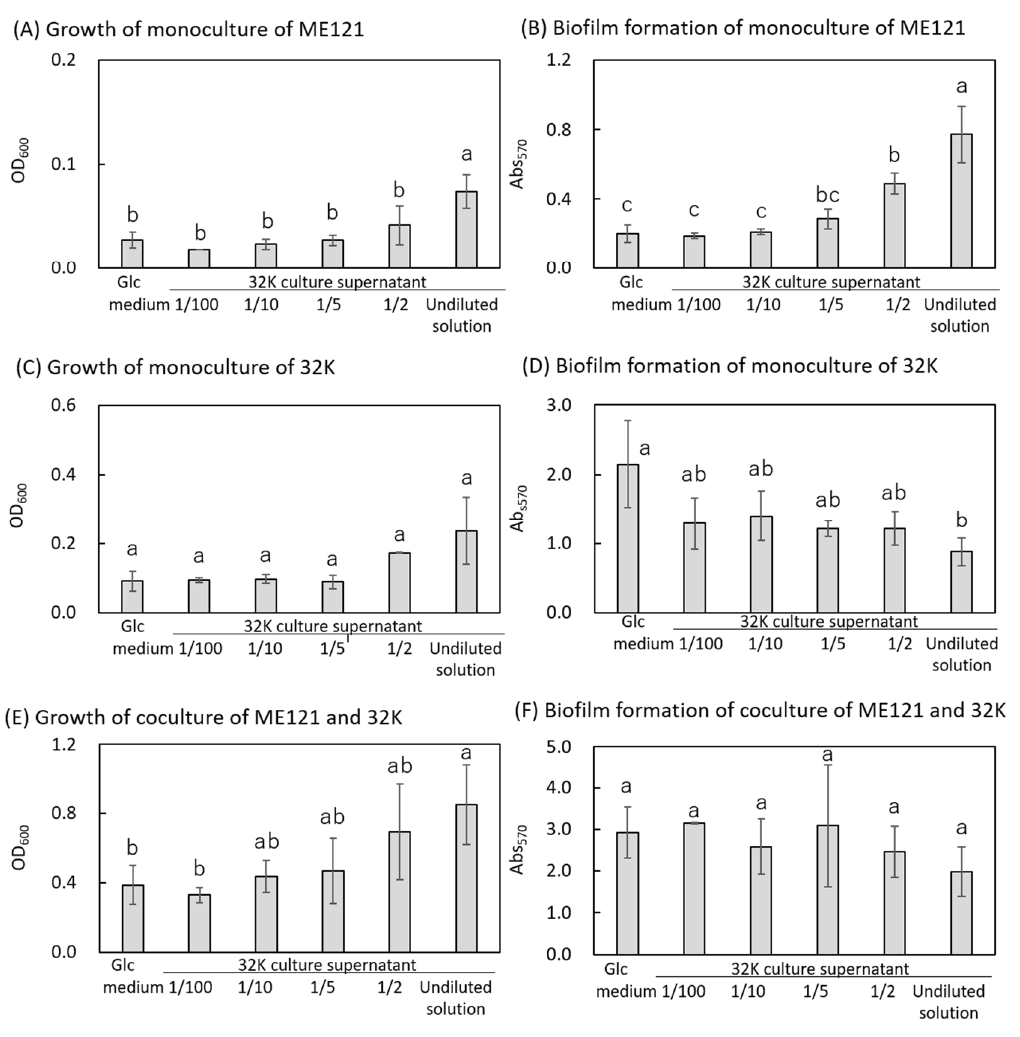
Figure 3. Growth and biofilm formation in monocultures of strains ME121 (A, B), 32K (C, D), coculture of strains ME121 and 32K (E, F), using culture supernatant of strain 32K diluted with Glc medium. Error bars are standard deviations. Two-way ANOVA test was performed for equality of all means; (A) F (5, 21) = 10.75, P < 0.001. (B): F (5, 21) = 23.05, P < 0.001, (C): F (5, 21) = 3.66, P < 0.05, (D) F (5, 21) = 2.50, P = 0.074, (E) F (5, 21) = 4.33, P < 0.05, (F) F (5, 21) = 0.59, P = 0.709. Tukey’s test was performed for post hoc analysis, P < 0.05. Different superscript letters (a, b, c) denote significant difference from each other in all combinations.